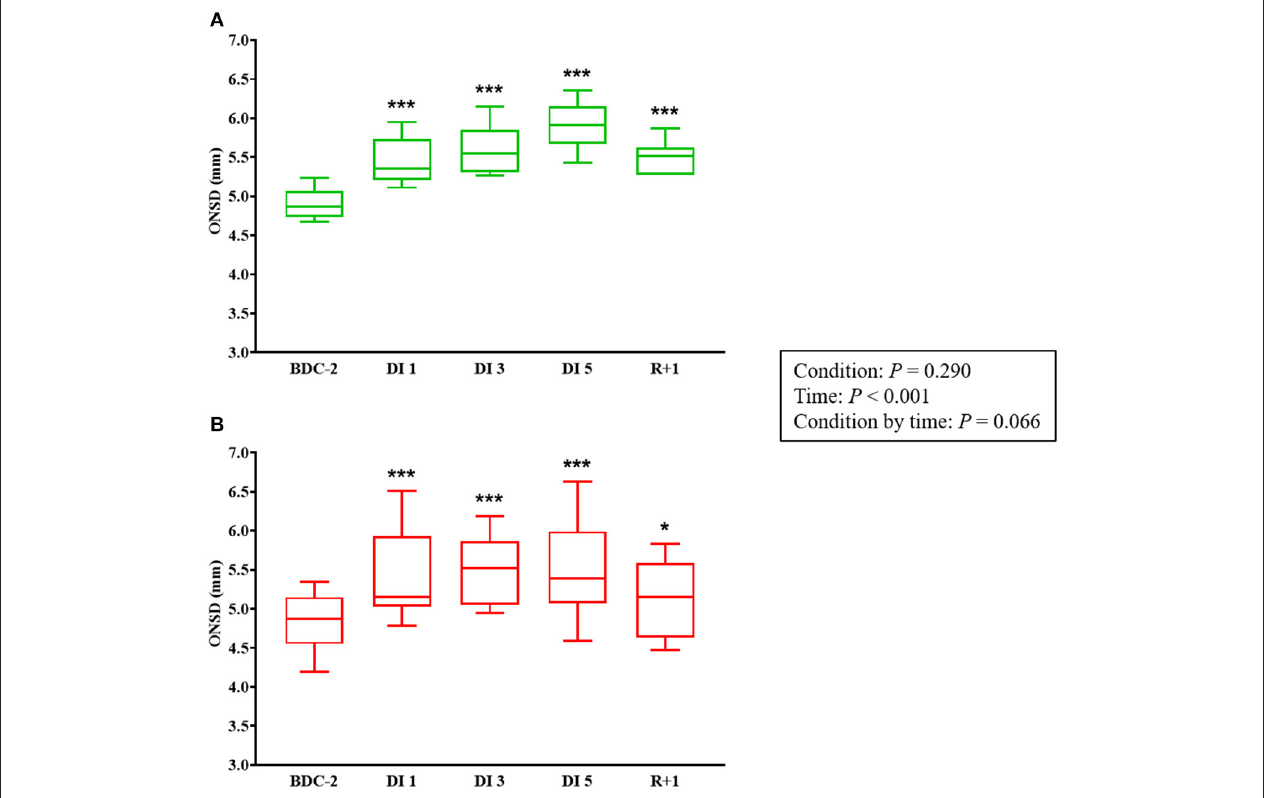
FIGURE 6 | ONSD measurements before, during, and after DI in control (A) and cuffs (B) groups. BDC-2, 2 days before DI; DI 1, first day of DI; DI 3, third day of DI; DI 5, fifth day of DI; ONSD, optic nerve sheath diameter; R + 1, first day after DI. * P < 0.05 vs. BDC-2, *** P < 0.001 vs.